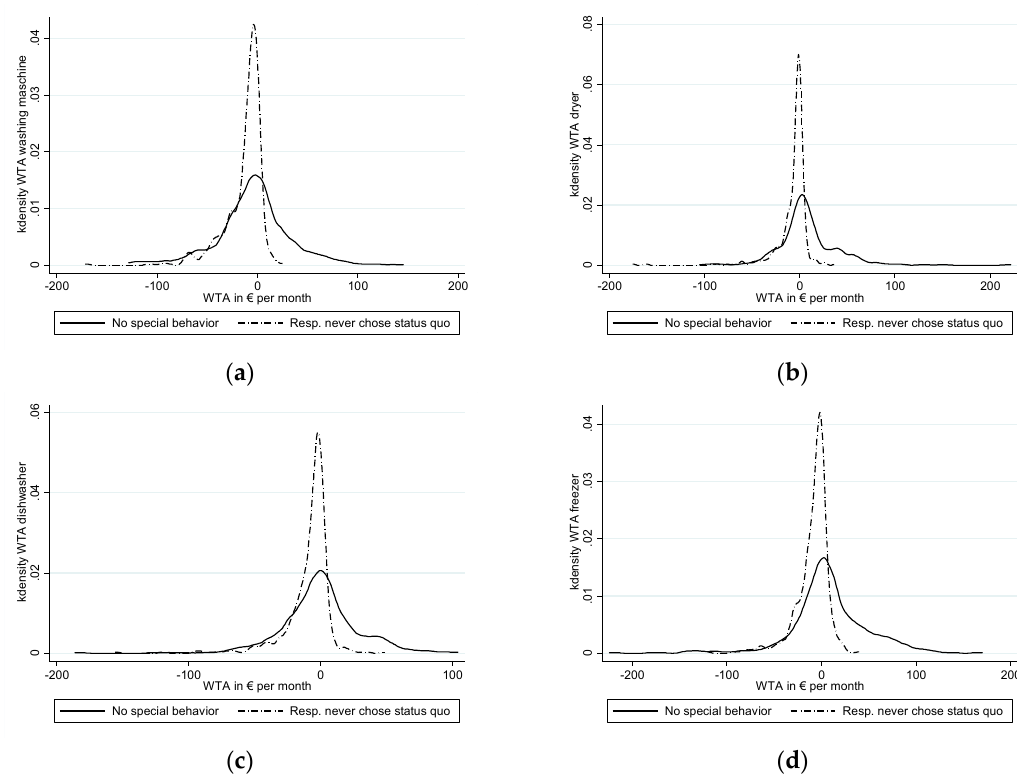
Figure 3. Kernel density estimates of conditional WTA by respondent groups and appliance. Continuous line: respondents without dominant strategy. Discontinuous line: respondents who never chose the status quo but not always the maximum discount. ( a ) Washing machine; ( b ) dryer; ( c ) dish washer; ( d ) freezer.